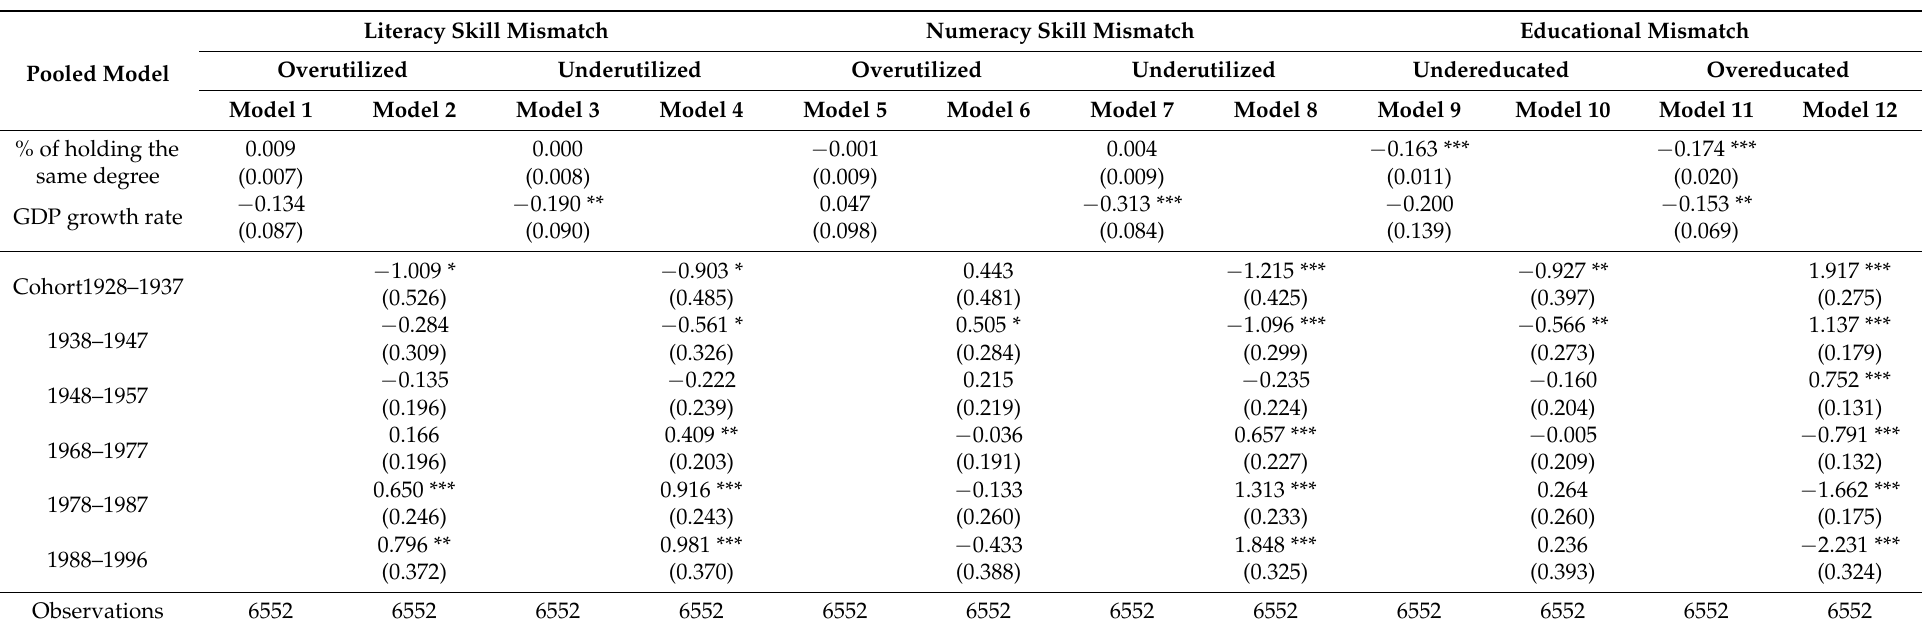
Table 7. Pooled model: cohort